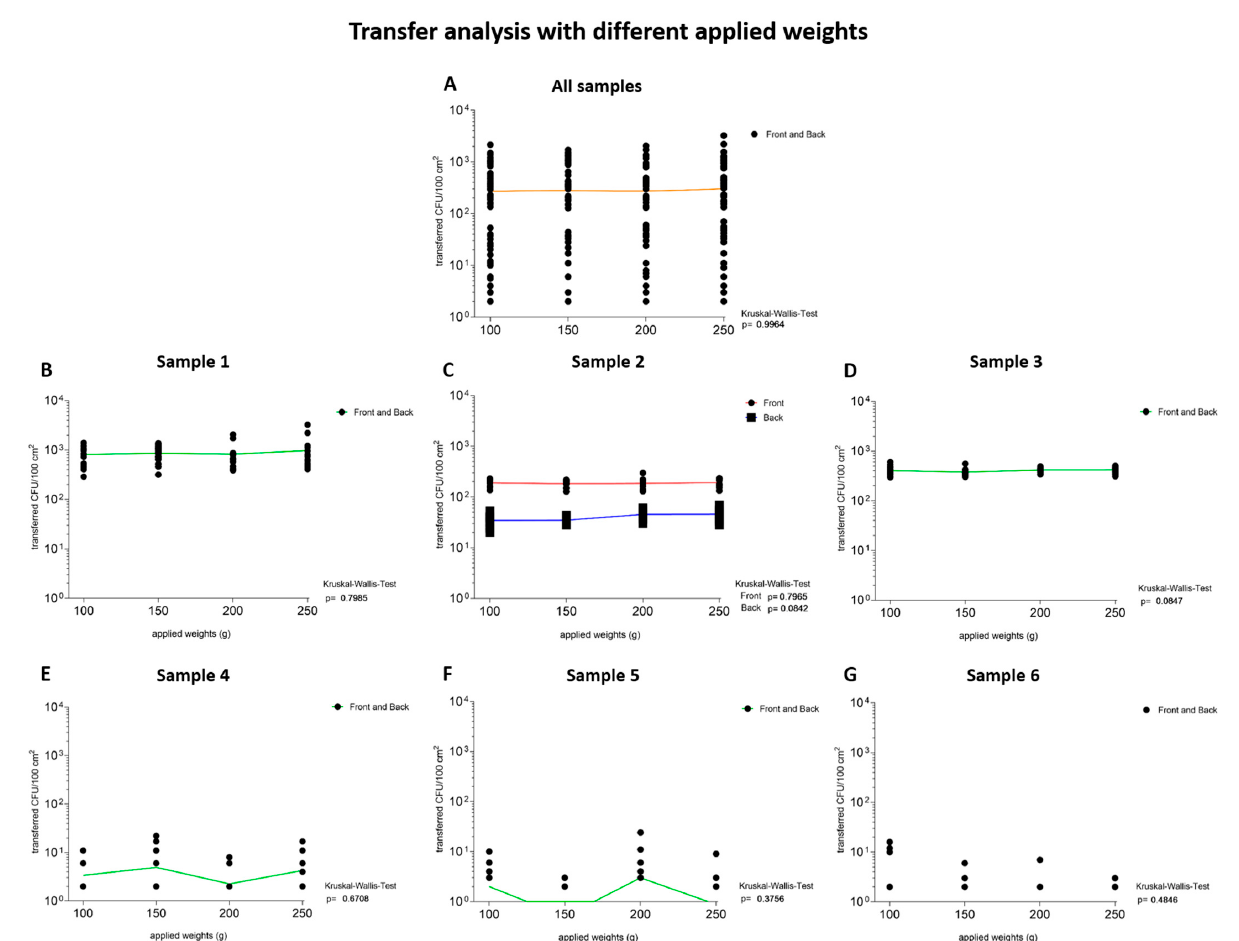
Figure 4. The transfer of colony-forming units per 100 square centimeters (CFU/100 cm 2 ) from packaging materials to contact media is independent of the applied weight. The applied weights in grams are listed in increasing order. The nodes (black) depict transferred CFU/100 cm 2 from the outer layers of the packaging material to the TSA plates after the samples were loaded with 100 g, 150 g, 200 g and 250 g for 30 min. The locally estimated scatterplot smoothing (LOWESS: orange) and the Kruskal–Wallis test were calculated to analyze the dependence on the applied weight of the transfer. Lines were drawn through the mean values of all measured data points to illustrate the dependence of the transfer on the tested parameter. Green lines illustrate data from both outer layers, while red lines represent data from the front and blue lines from the back. A p -value of below 0.05 was defined as statistically significant. With increasing applied weight, the transferred CFU/100 cm 2 did not increase significantly ( p > 0.05). Therefore, the transfer is independent of the applied weight in this experiment. ( A – G ) The graphs indicate no weight dependent transfer of microorganisms over all tested samples ( p > 0.05). Table 3. Transfer of microorganisms from samples to tryptone soy agar (TSA) plates tested with different applied weights. The samples are labeled with respect to their numbers of colony-forming units per 100 square centimeters (CFU/100 cm 2 ) in descending order (1–6). The experimental set-up was performed as described in Figure 2(1). Data are shown as mean ± SD. The transfer ratios are declared as a percentage (%). A p -value of <0.05 was defined as statistically significant. Sample Number